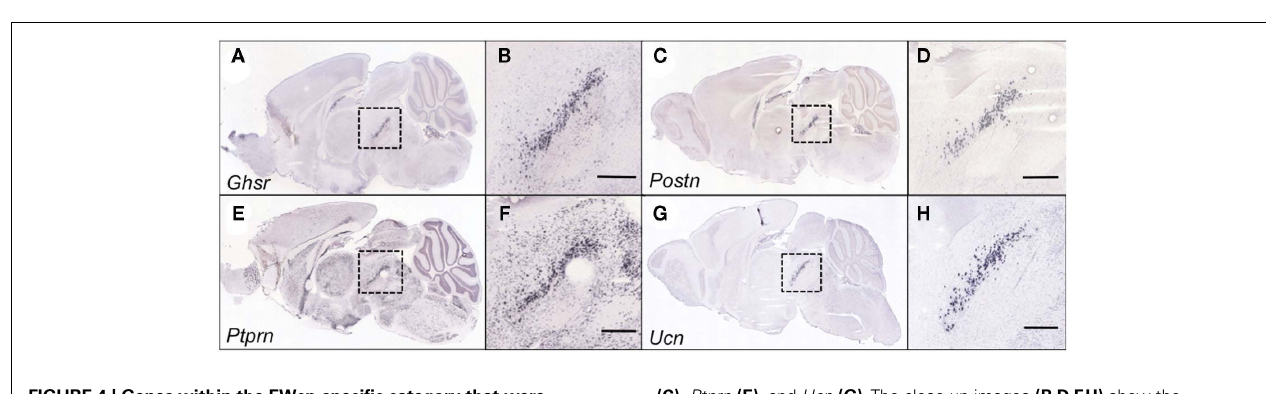
FIGURE 4 | Genes within the EWcp-specific category that were identified as being differentially expressed between B6 and D2 mice are indeed EWcp-specific. Shown are sagittal slices at the midline from adult male B6 mouse brains that have undergone in situ hybridization to reveal the EWcp-specific expression of Ghsr (A) , Postn